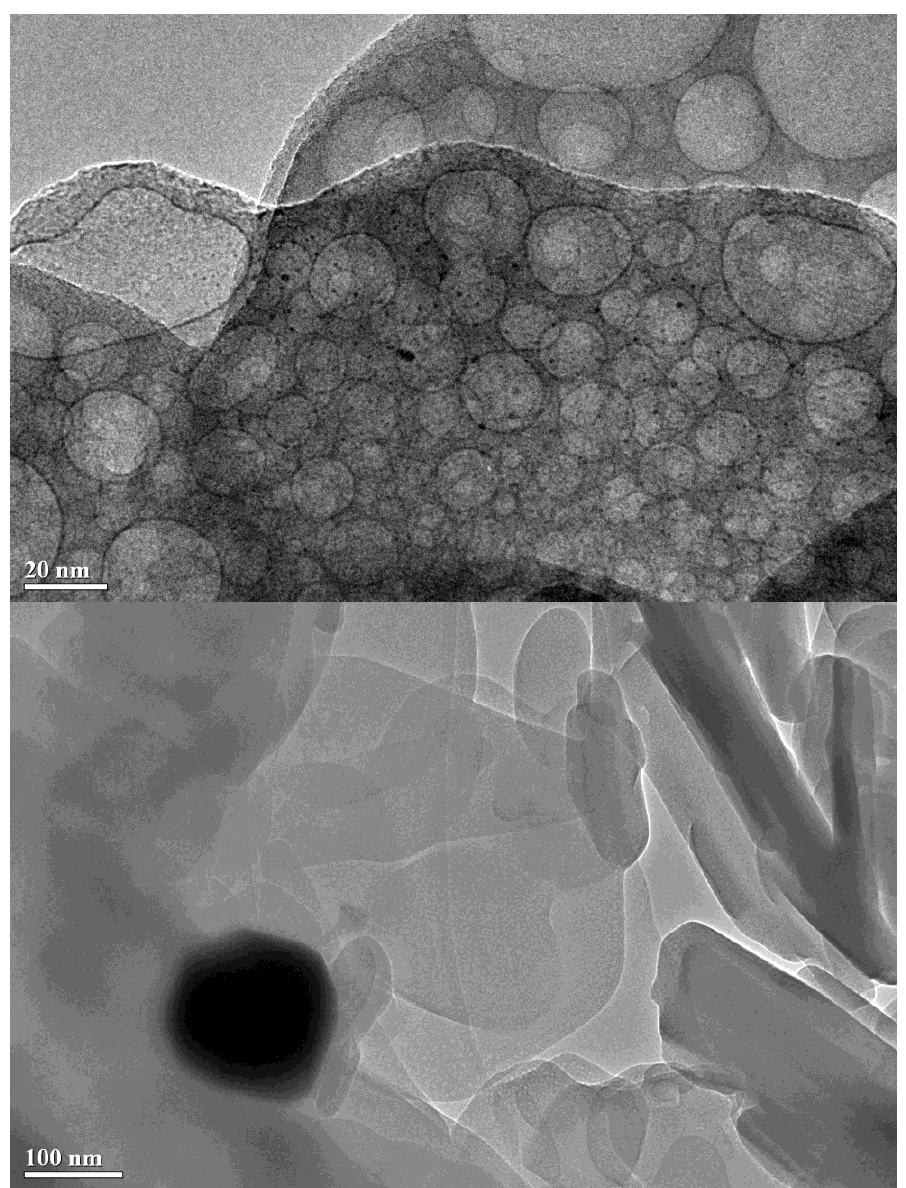
Figure 3. TEM image of spent Pt/Mg-P-O (calcined at 500 °C, pretreated in 4% H 2 at 300 °C, and tested in CO